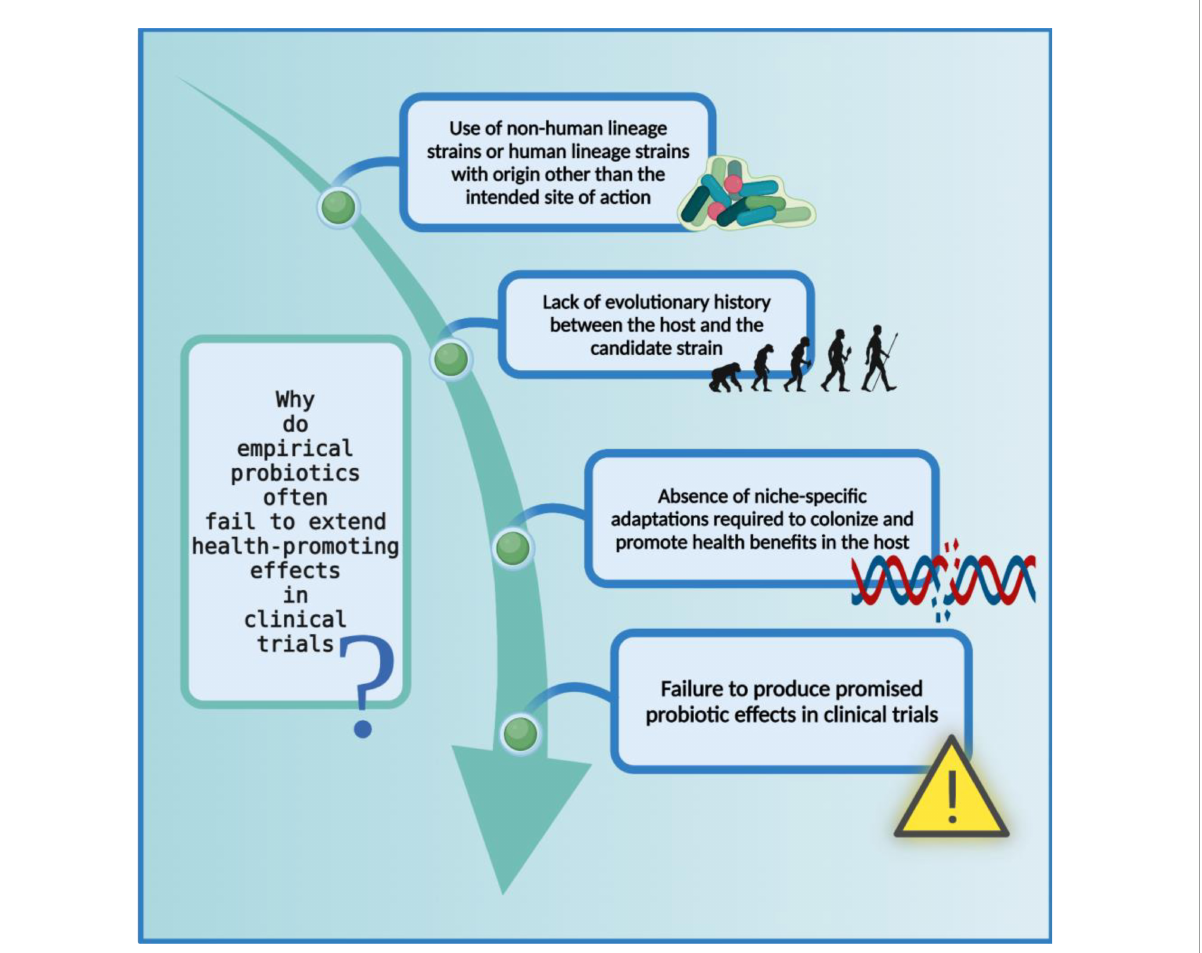
FIGURE4 Limitations of non-human lineage strains as probiotics. The probiotic formulations based on non-human associated strain often fail to produce health-promoting effects in clinical trials possibly because they did not co-evolve with their respective host and consequently do not carry niche-specific genetic modifications. The figure was drawn with